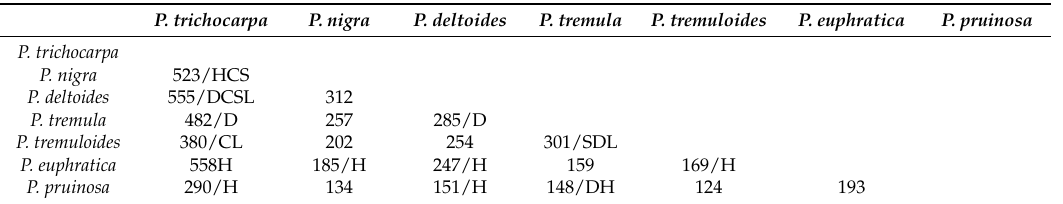
Table 3. Positive selection orthologues in genus Populus .